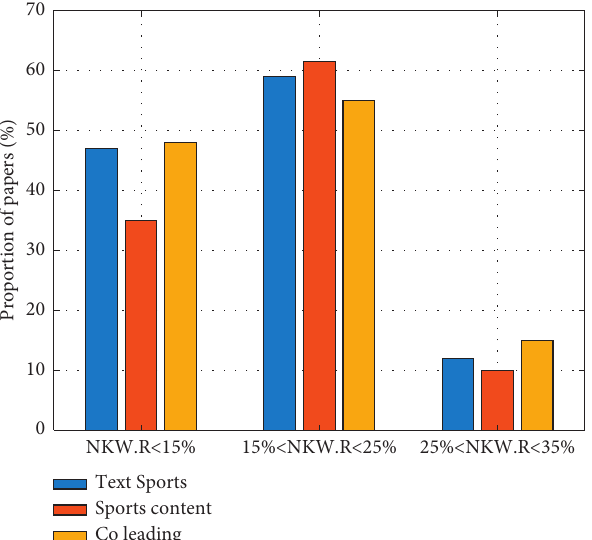
Figure 9: Percentage of each dominant type in different stages of